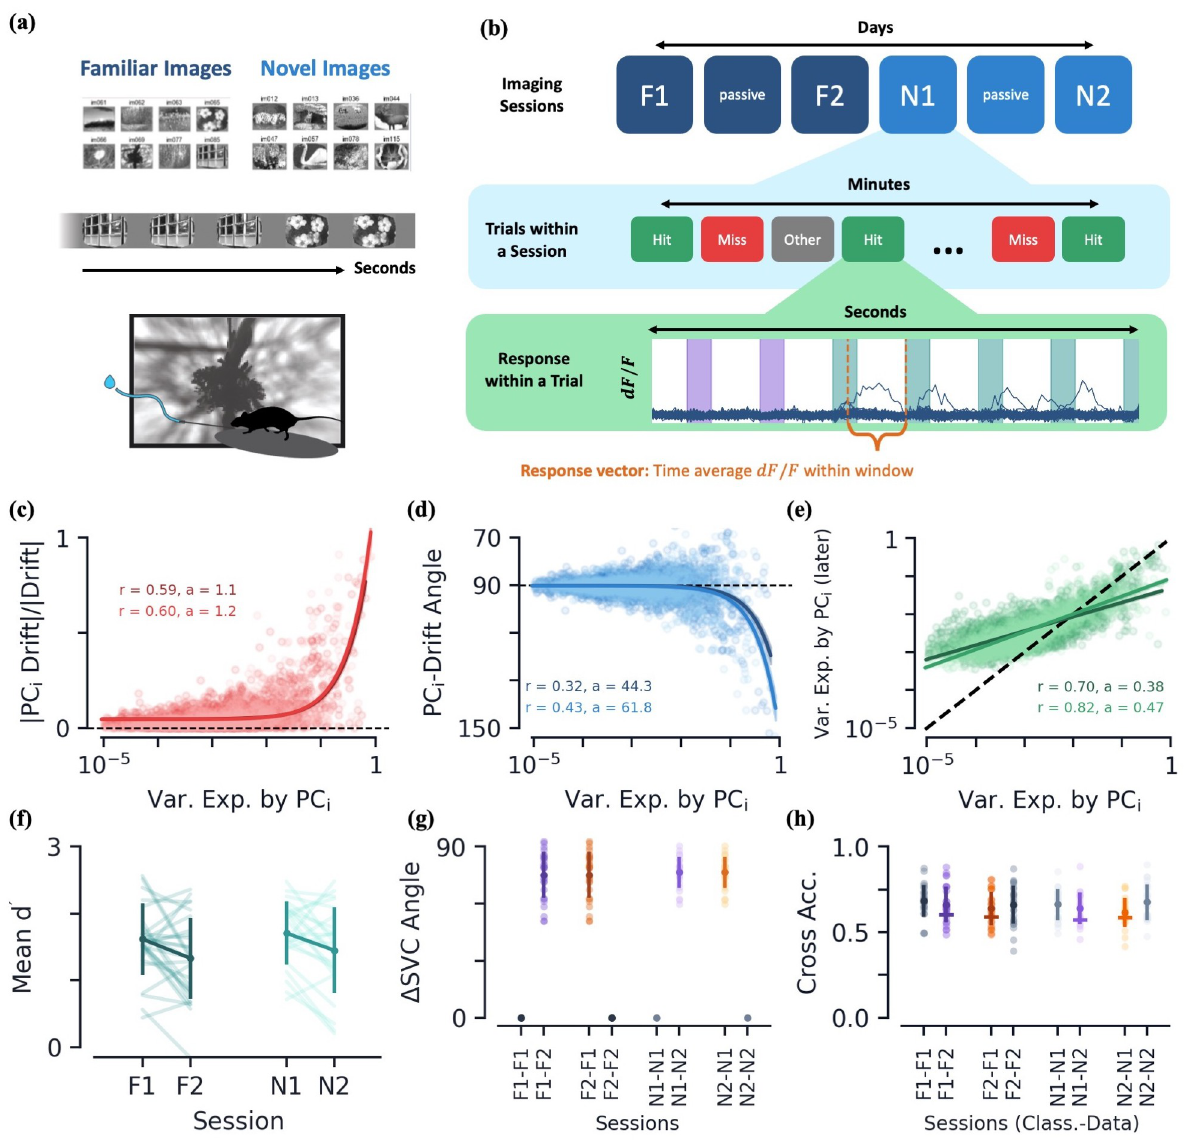
Fig 4. Behavioral data: Experimental setup and drift geometry. (a) Summary of experimental setup. (b) Summary of session ordering, trial types, and extraction of response vectors from dF / F values. Bottom plot shows dF / F values over time, with colored columns representing image flashes where different colors are different images. [c-e] Various drift metrics of Hit trials and their dependence on PC direction of the earlier session’s i variational space. Dark colors correspond to drift between familiar sessions, while lighter colors are those between novel sessions. Metrics are plotted as a function of each PC ’s ratio of variance explained, v . Colored curves are again linear regression fits. (c) Magnitude of drift along a given PC i i i direction, relative to full magnitude of drift. (d) Angle of drift with respect to PC i direction. (e) Post-drift variance explained along PC i direction (dotted line is equality). Linear regression fit to log(var. exp). [f-h] Various metrics as a function of session(s). Dark solid dots/lines show mean values with ± s.e. Light colored dots/lines show raw mice data. (f) Mean performance metric over engaged trails, d 0 (Methods). (g) Angle between SVC normal vectors. (h) Cross classification accuracy, as a function of trained data session (Class.) and tested data session (Data). The “–” marker again shows average classification accuracy when SVCs are randomly rotated by same angle that separates respective sessions’ classifiers.